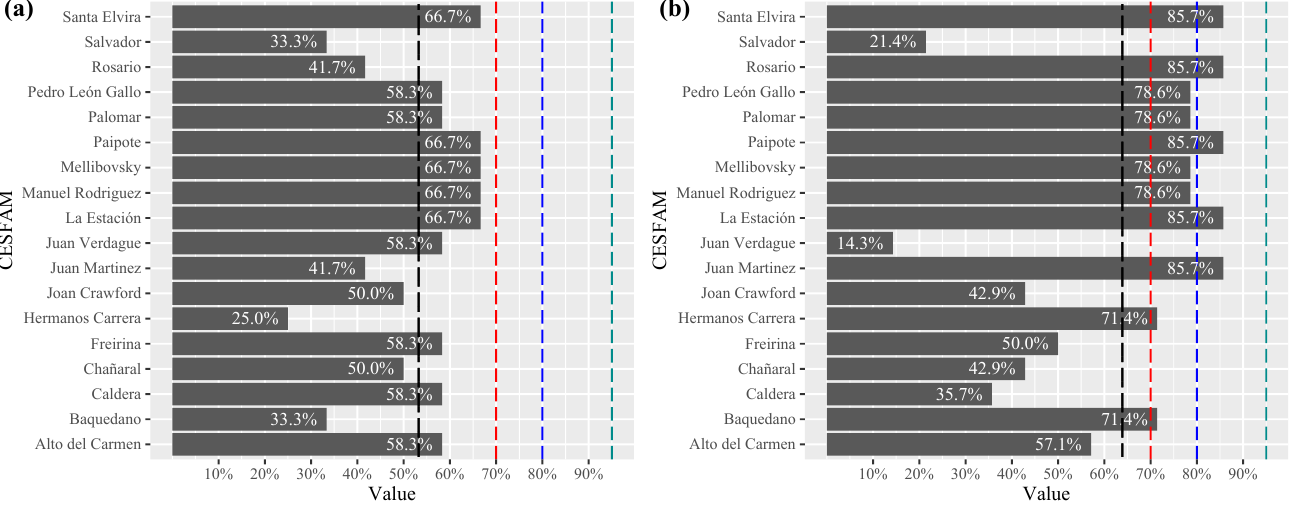
Figure 6. Level of compliance with the ( a ) third access chain, ( b ) architectural. (Family Healthcare Center (CESFAM), mean dash – – black, lim 70% dash – – red, 80% dash – – blue and 95% dash – –